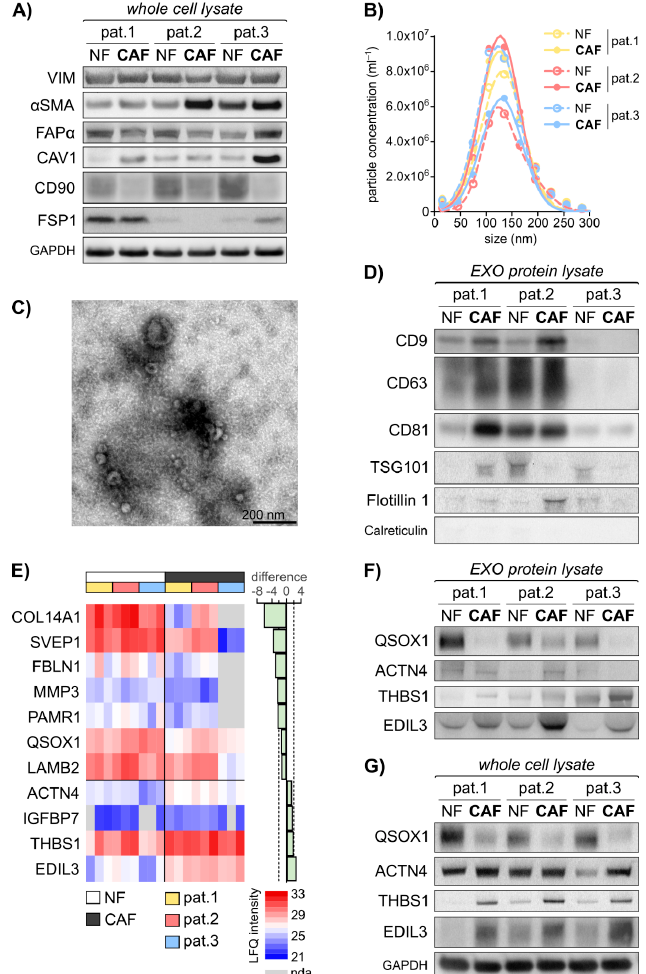
Figure 1. Primary fibroblast-derived EXOs display an activation status dependent protein cargo. The established fibroblast cell lines were subjected to cellular protein isolation after 48 h incubation of equal cell numbers in normal growth medium. EXOs were isolated using combined differential centrifugation and ultrafiltration approach following 48 h of fibroblast incubation in starvation medium. Exosomal protein was isolated in biological triplicates and subjected to Mass Spectrometry. Statistical Analysis was performed in Perseus. ( A ) Immunoblot analysis of vimentin (VIM), α - smooth-muscle actin ( α SMA), fibroblast activation protein α (FAP α ), caveolin 1 (CAV1), cluster of differentiation 90 (CD90)/Thy1 and fibroblast-specific protein 1 (FSP1) in primary fibroblasts, including GAPDH as loading control. ( B ) Particle size distribution in the isolated EXOs (mean of n = 4–10) as measured by nanoparticle tracking analysis (NTA) using ZetaView ® . ( C ) Representative transmission electron microscopy (TEM) image of fibroblast-derived EXOs. ( D ) Immunoblot analysis of EXO markers CD9, CD63, CD81, Flotillin 1 and Tumor susceptibility 101 (TSG101), including calreticulin as negative control. ( E ) Heat map of mass spectrometry data illustrating significantly deregulated vesicular proteins. Proteins with more than 4 undefined values in total or more than 3 undefined values in the NF/CAF subgroups are excluded. Paired t test: q < 0.05, diff. >